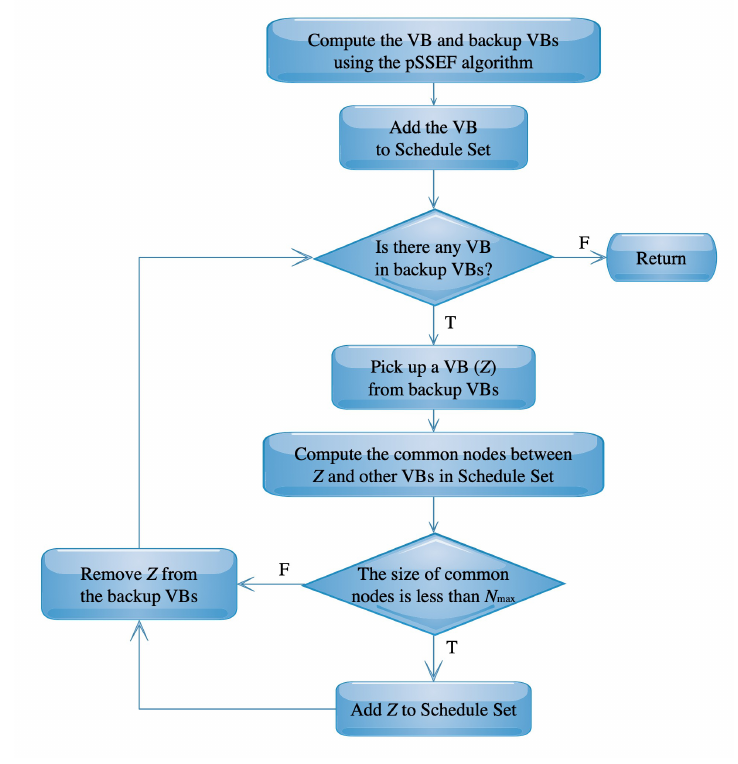
Figure 6. The SC-pSSEF